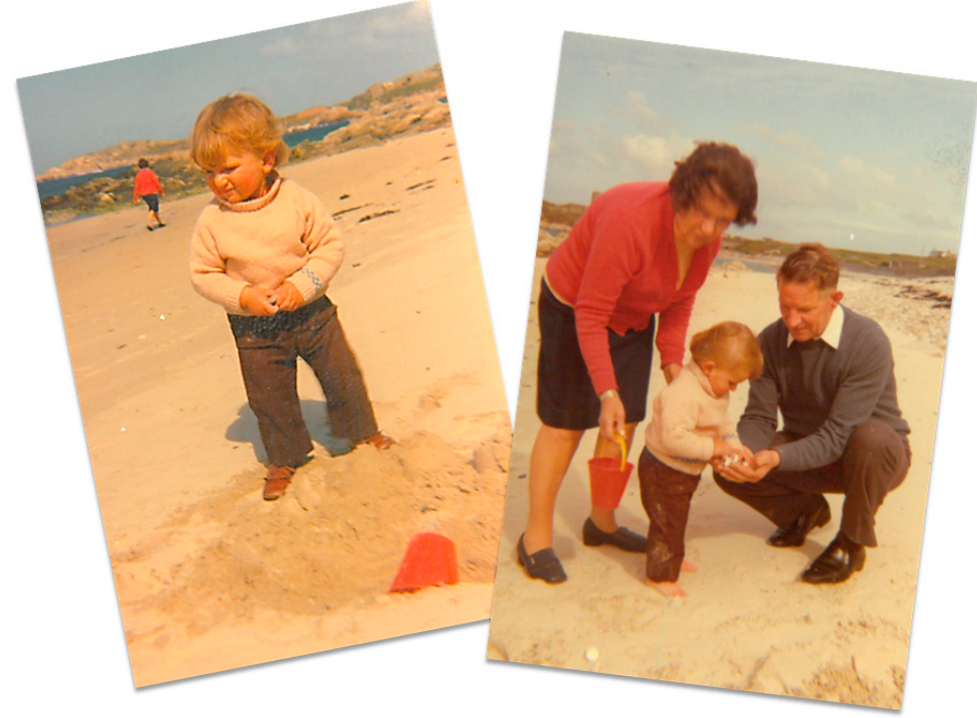
Figure 5. Montage of childhood photos: the author, sand, and family memories (photos: author).